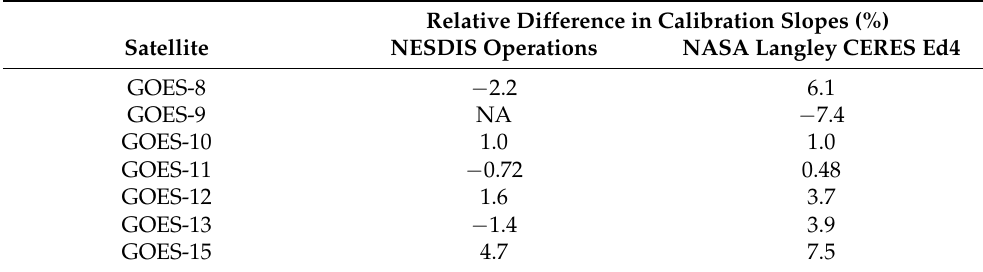
Table 5. Comparison of calibration slopes between values derived here and those provided by NESDIS operations for each GOES-IP